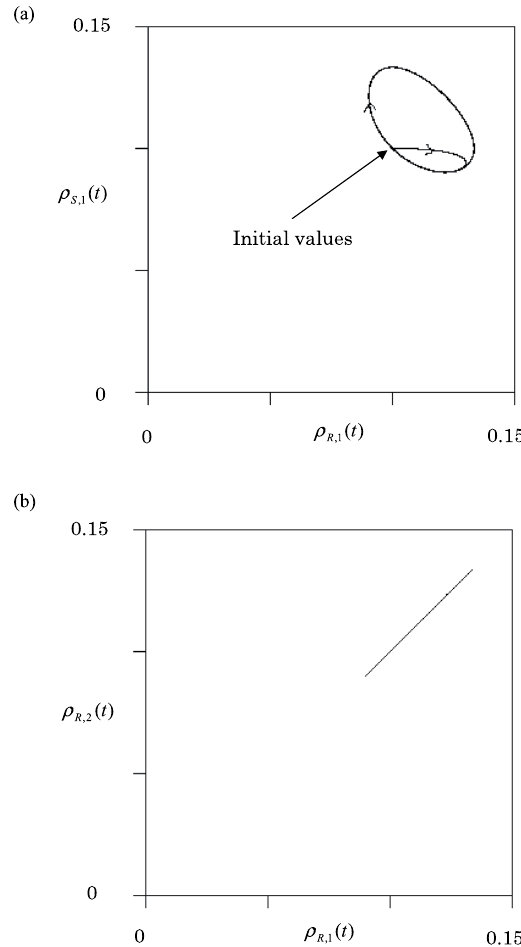
Figure 3. The orbits for homogeneous graph. ( a ) The scissors density ρ is plotted against the rock density in node 1. ( b ) Plots of rock density